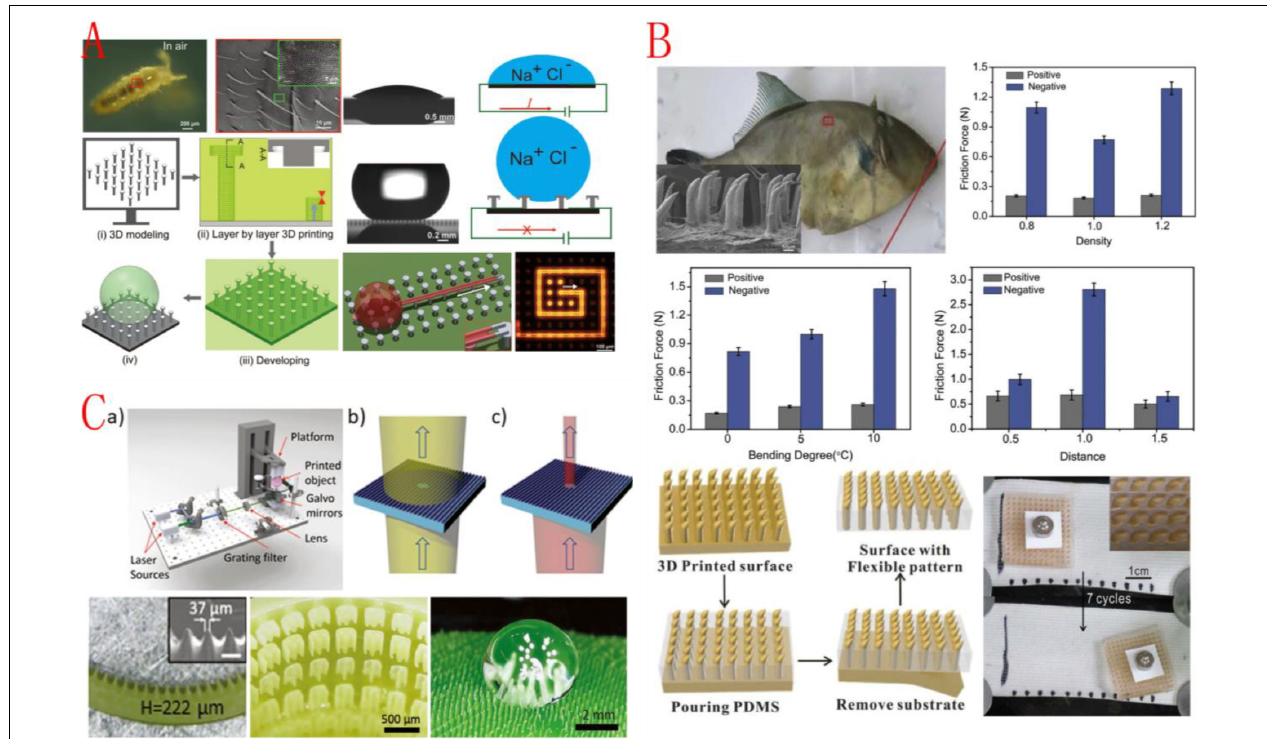
FIGURE 5 | (A) Triply re-entrant structures inspired by Folsomia candida, fabricated via two-photon polymerization based 3D printing technology (Liu et al., 2018). Reproduced with the permission of 2018 WILEY-VCH Verlag GmbH & Co. KGaA, Weinheim. (B) 3D printed friction anisotropic surfaces, inspired by the surface structures of the Filefish skin (Ji et al., 2018). Reproduced with the permission of 2018 Elsevier Ltd. (C) Low-cost multiscale stereolithography technology, used to print a macroscale object with microscale surface structures, inspired by shark skins and lotus leaf (Li et al., 2019b). Reproduced with the permission of 2019 WILEY-VCH Verlag GmbH & Co. KGaA,